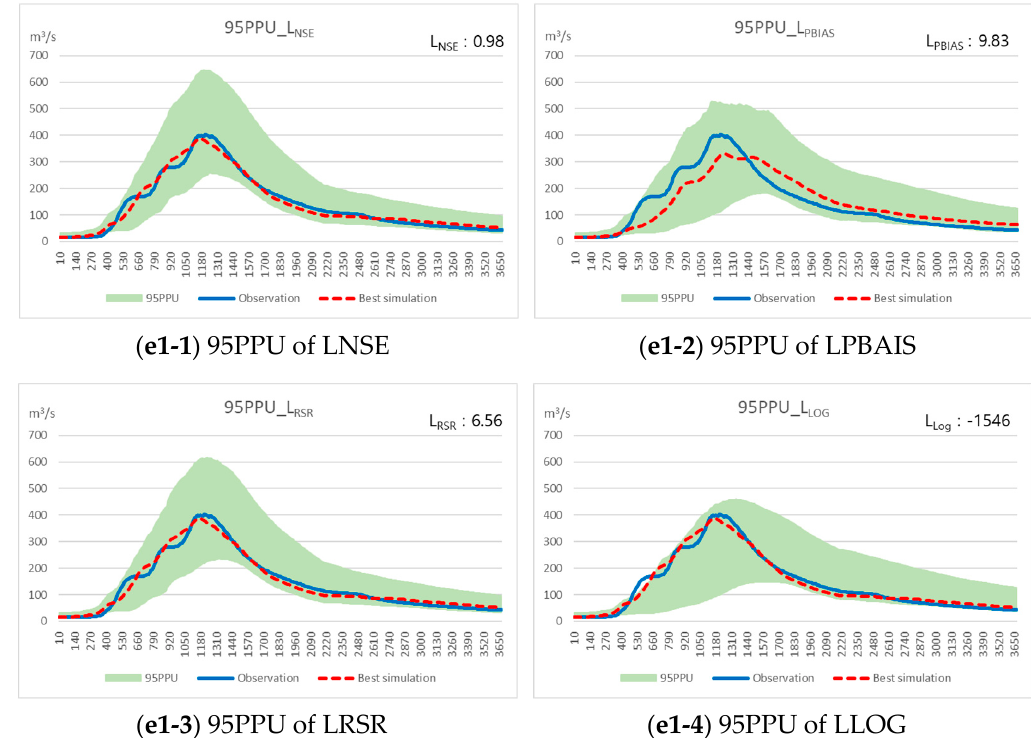
Figure 9. Event 1 95PPU. ( e1-1 ) LNSE results; ( e1-2 ) LPBIAS results; ( e1-3 ) LRSR results; ( e1-4 ) LLOG results.